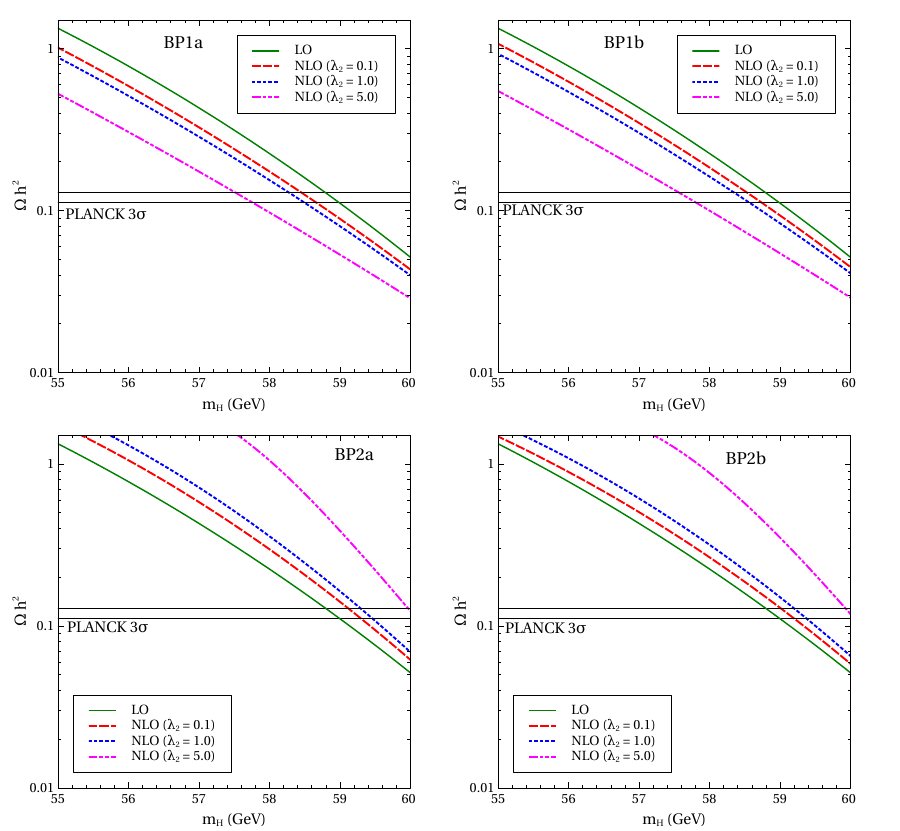
Figure 3 . Variation of the thermal relic with the DM mass (55 GeV < m H < m h = 2). The tree level and one-loop values are denoted by the green solid and red dashed ( (cid:21) 2 = 0 : 1), blue dotted ( (cid:21) 2 = 1) and pink dot-dashed ( (cid:21) = 5)